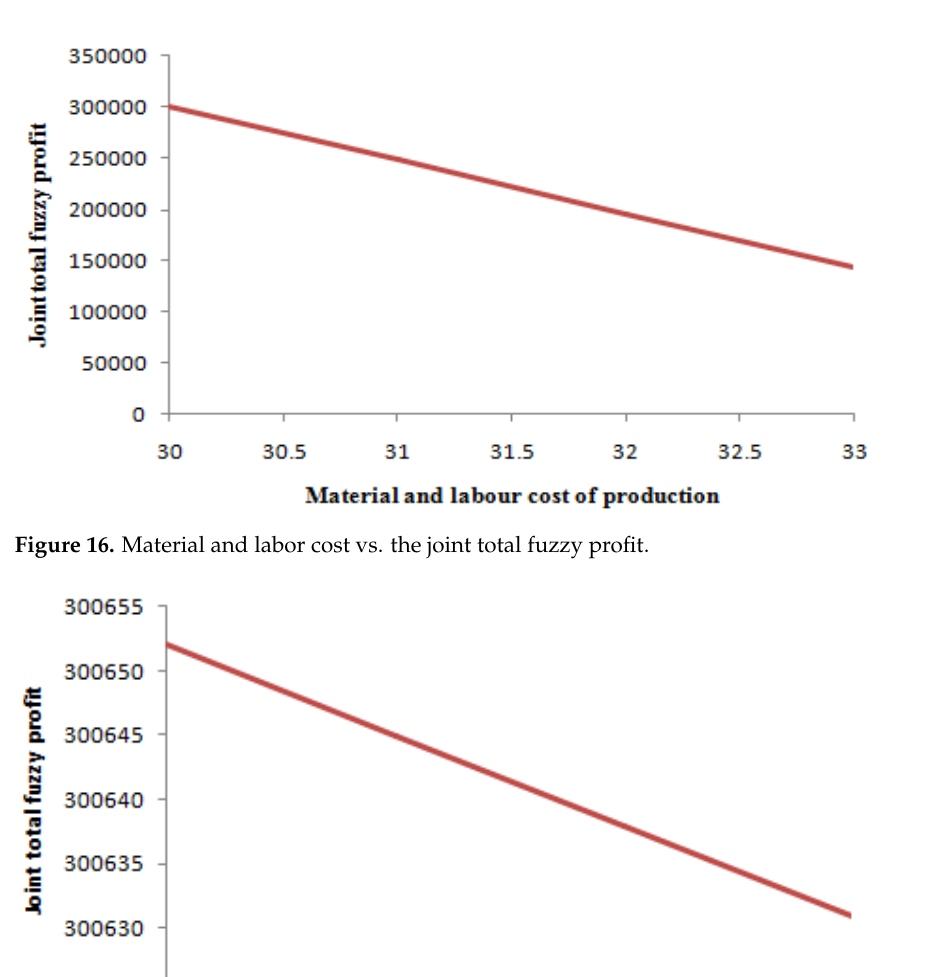
Figure 15. Upper and lower deviation of the demand rate vs. the joint total fuzzy profit.